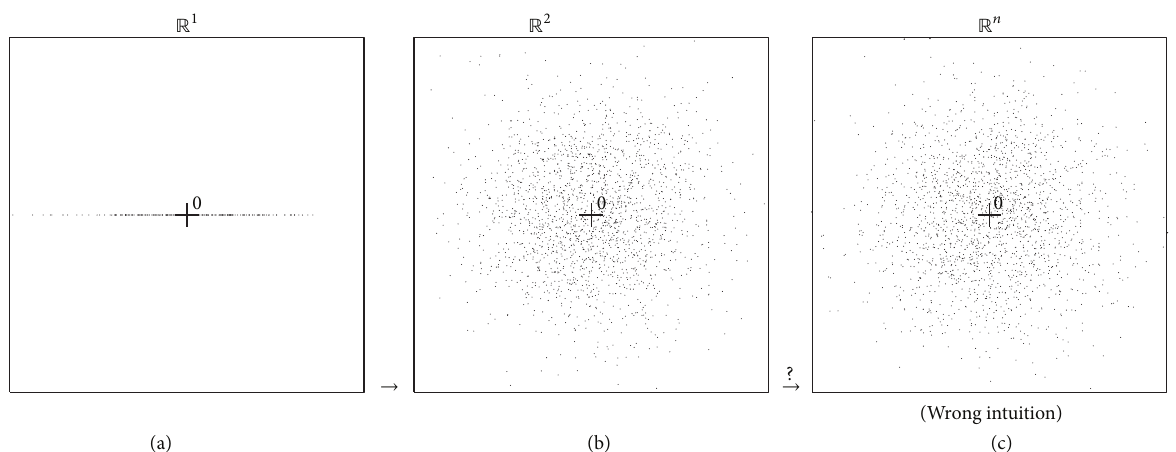
Figure 1: Wrong intuitive extrapolation of Gaussian samples distribution from dimension 1 (a) to dimension 𝑛 (c).